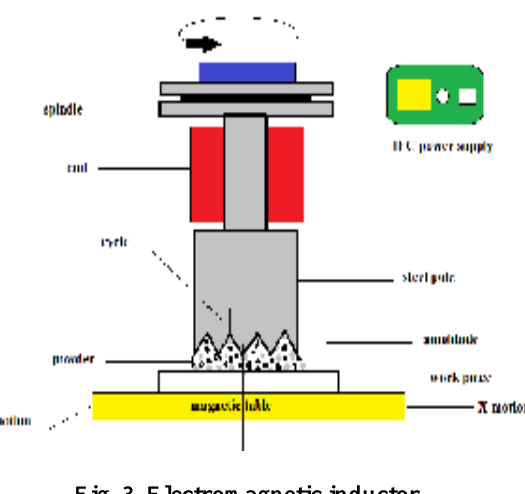
Fig. 3. Electromagnetic